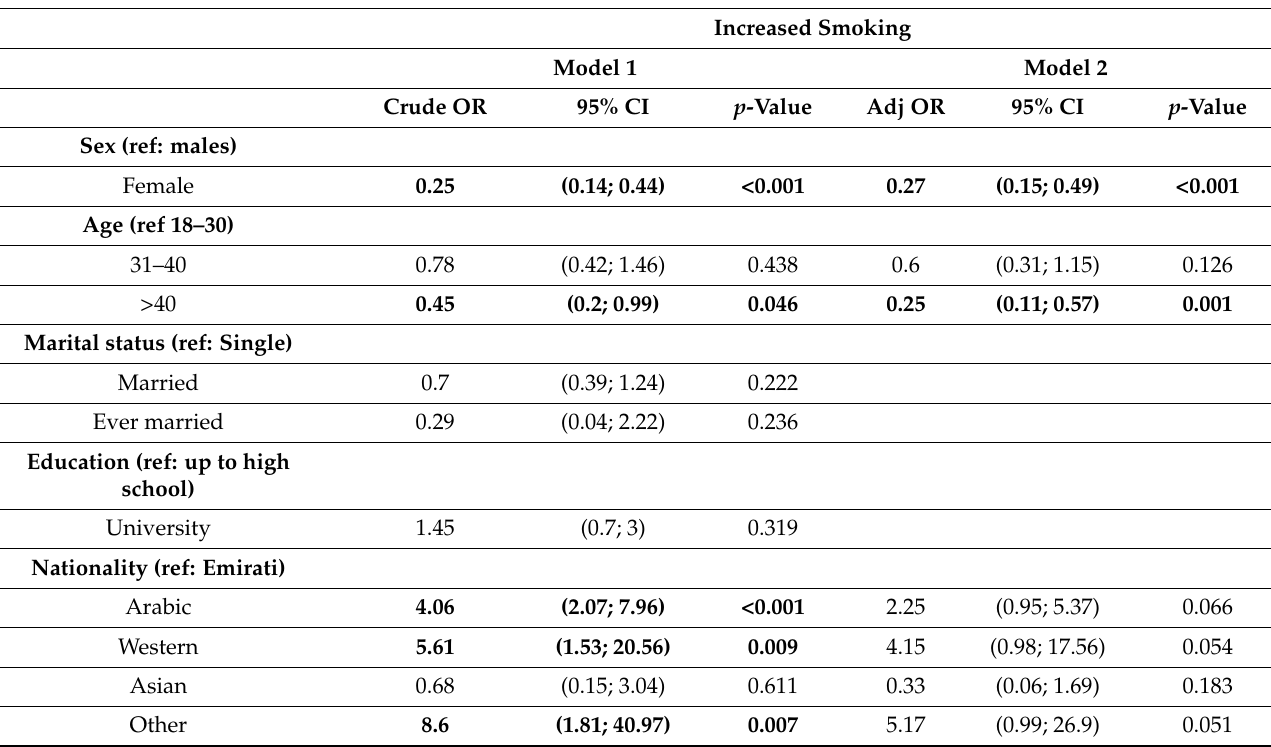
Table A5. Simple and multiple logistic regressions describing the association between increased smoking and sociodemo- graphic characteristics in the study population ( n =